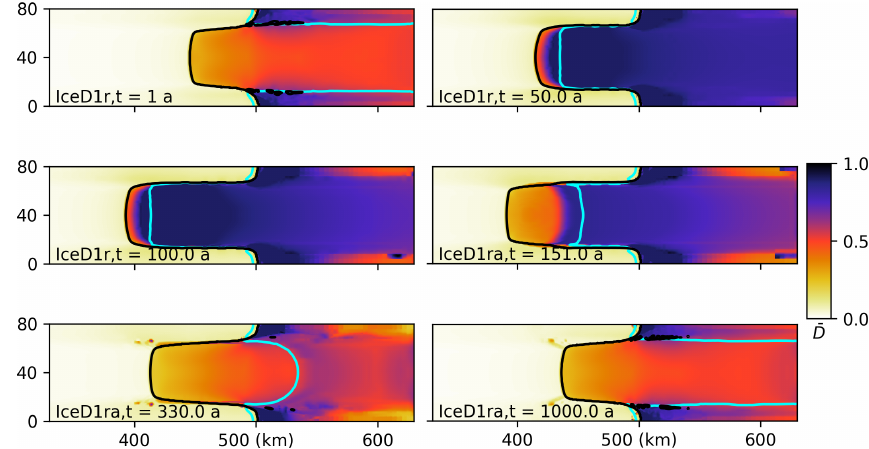
Figure 5. Comparison of the retreat and recovery due to changes in ice shelf basal melt (IceD1rr and IceD1ra) in MISMIP + . IceD1r sees the grounding line (solid black contour) in the centre of the channel retreat to x = 390km over 100 years in response to strong ablation across the whole ice shelf. Parts of the ice shelf are thin ( h < 200m, outside cyan contour) so that a high value of D implies only a small reduction in buttressing from those regions. IceD1ra follows directly from IceD1r, setting the melt rate to zero so that the ice shelf thickness and the grounding line readvances, recovering its original shape after around 1000